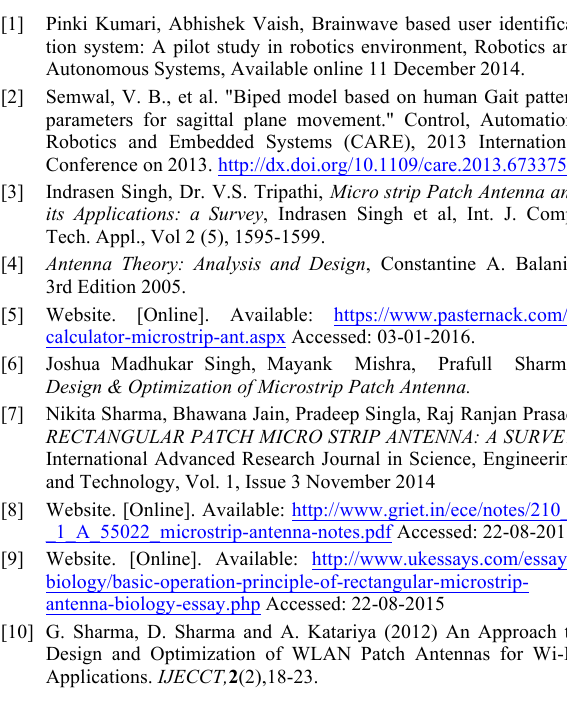
TABLE III. P ERFORMANCE O F T HE D ESIGNED M ICROSTRIP P ATCH A NTENNA F OR 6 D IFFERENT D IELECTRIC M ATERIALS A T 5.8 G HZ R ESONANT F REQUENCY